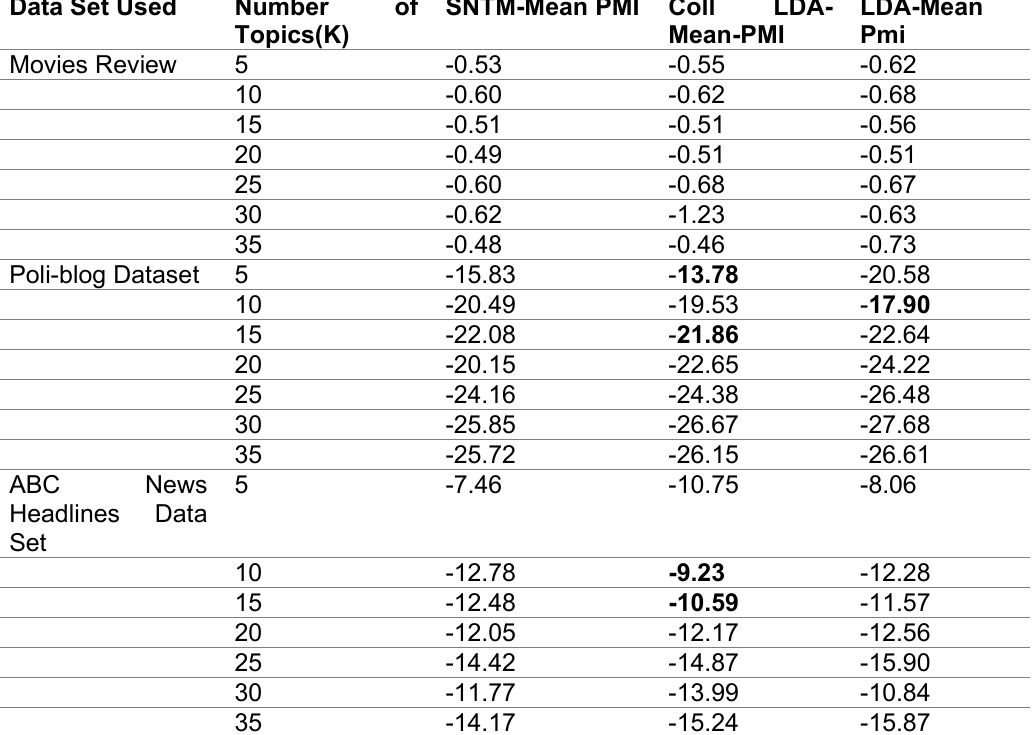
Table 2. Coherence score of LDA topic model and Semantic N-Gram topic modeling with different number of